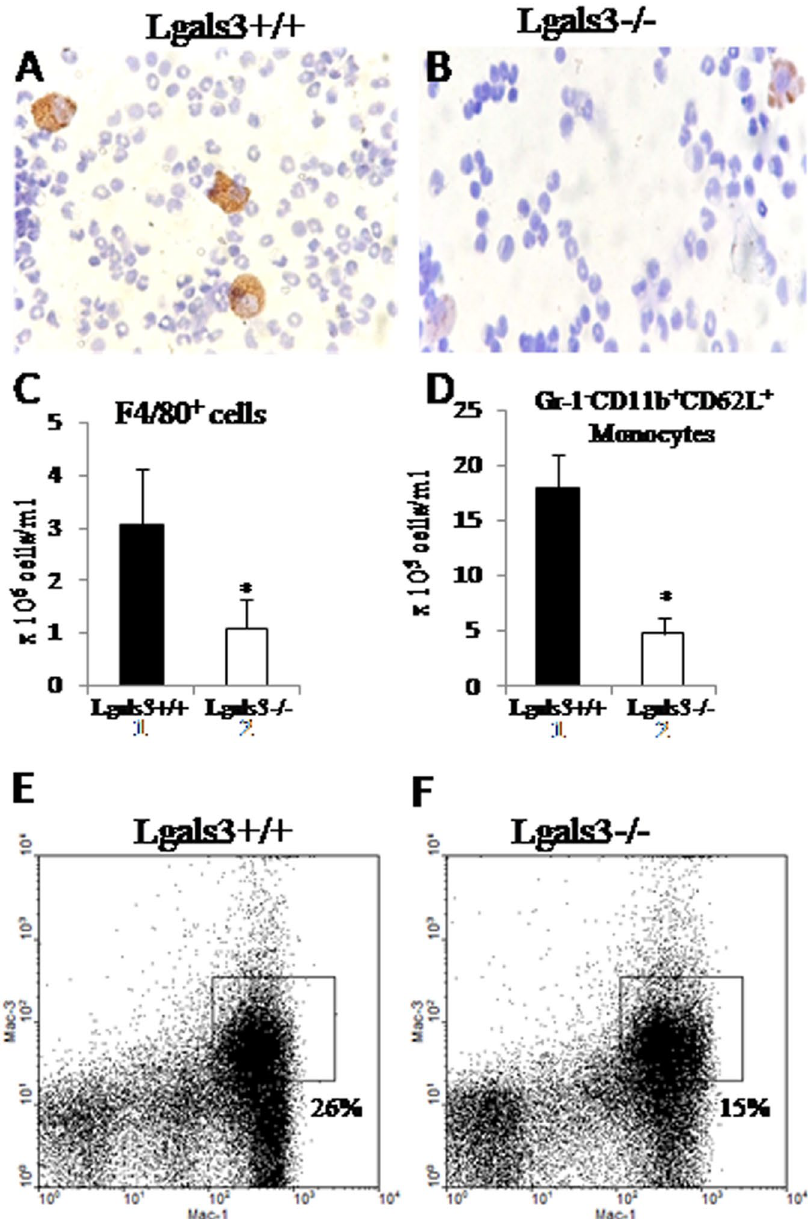
Figure 4. Analysis of peritoneal monocytes and macrophages recovered 18 h after pristane injection. Immunocytochemistry to identify F4/80 + peritoneal cells in cytosmears of pristane-induced Lgals3 + / + mice ( A ) and Lgals3 − / − mice ( B ). Bar graphs indicate the absolute number of F4/80 + cells ( C ) and Gr-1 - CD11b + CD62L + monocytes ( D ) in the peritoneal fluid. Black bars represent Lgals3 + / + mice whereas white bars represent Lgals3 − / − mice. Total phagocytes were quantified by flow cytometry according co-expression of Mac-1/Mac-3 in Lgals3 + / + mice ( E ) and Lgals3 − / − mice ( F ). Data are representative of three independent experiments. Magnification: A-B (200 × ). ( * ) indicates p <